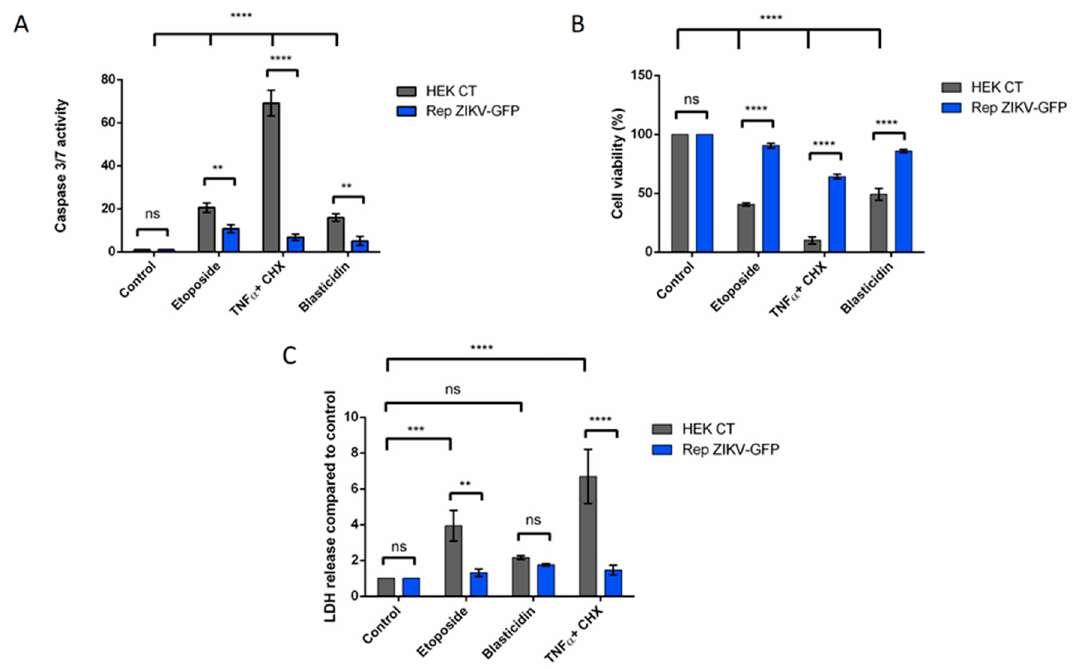
Figure 6. ZIKV replicon-expressing cells are protected from apoptosis. HEK-293 cells stably expressing a ZIKV replicon (Rep ZIKV-GFP) are protected from intrinsically and extrinsically mediated apoptosis. HEK-293 cells with Rep ZIKV-GFP were treated with TNF α and CHX for 6 h, or treated with etoposide 10 µ M or blasticidin 25 µ g / mL − 1 for 16 h and analyzed for: caspase 3 / 7 activity ( A ), cell viability (MTT assay) ( B ) and released LDH activity ( C ). Values represent the mean and standard deviation obtained with three di ff erent clones of Rep ZIKV-GFP. Values represent the mean and standard deviation of three independent experiments. Data were analyzed by a one-way ANOVA test with post-hoc Tukey’s test (** p < 0.01; *** p < 0.001, **** p < 0.0001, ns = not significant).